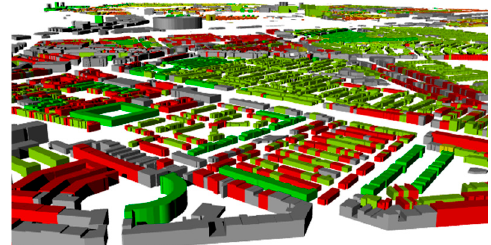
Figure 7. Rendered 3D close-up image of the Feijenoord district’s heat demand.